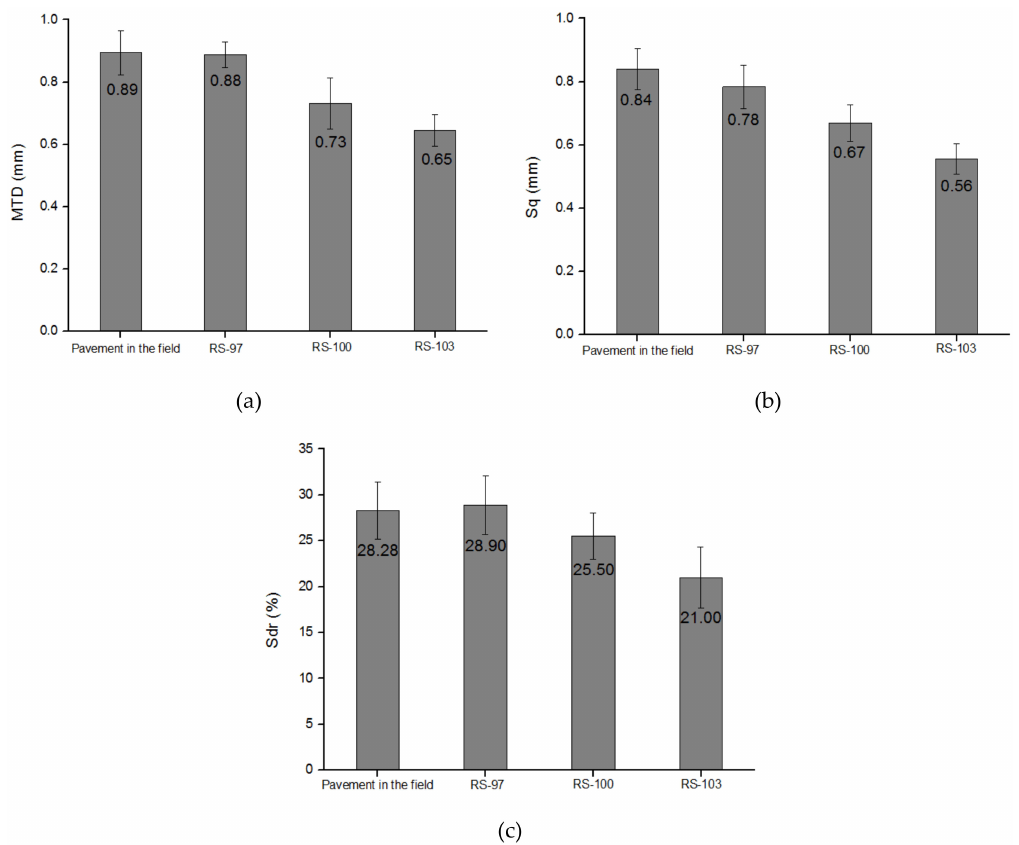
Figure 8. Surface texture parameters without load repetitions. ( a ) MTD; ( b ) Sq ; and ( c ) Sdr